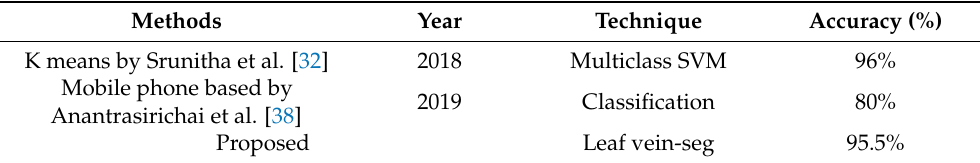
Table 8. Comparison of different segmentation and classification techniques with proposed